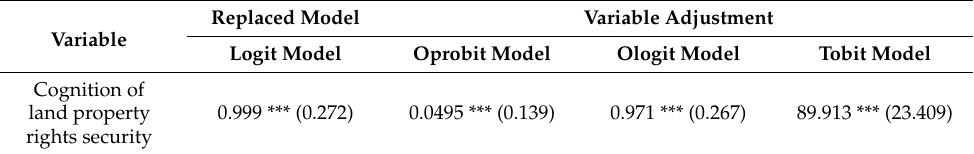
Table 3. Robustness test results of the impact of land property security awareness on the amount of farmyard manure applied per unit land